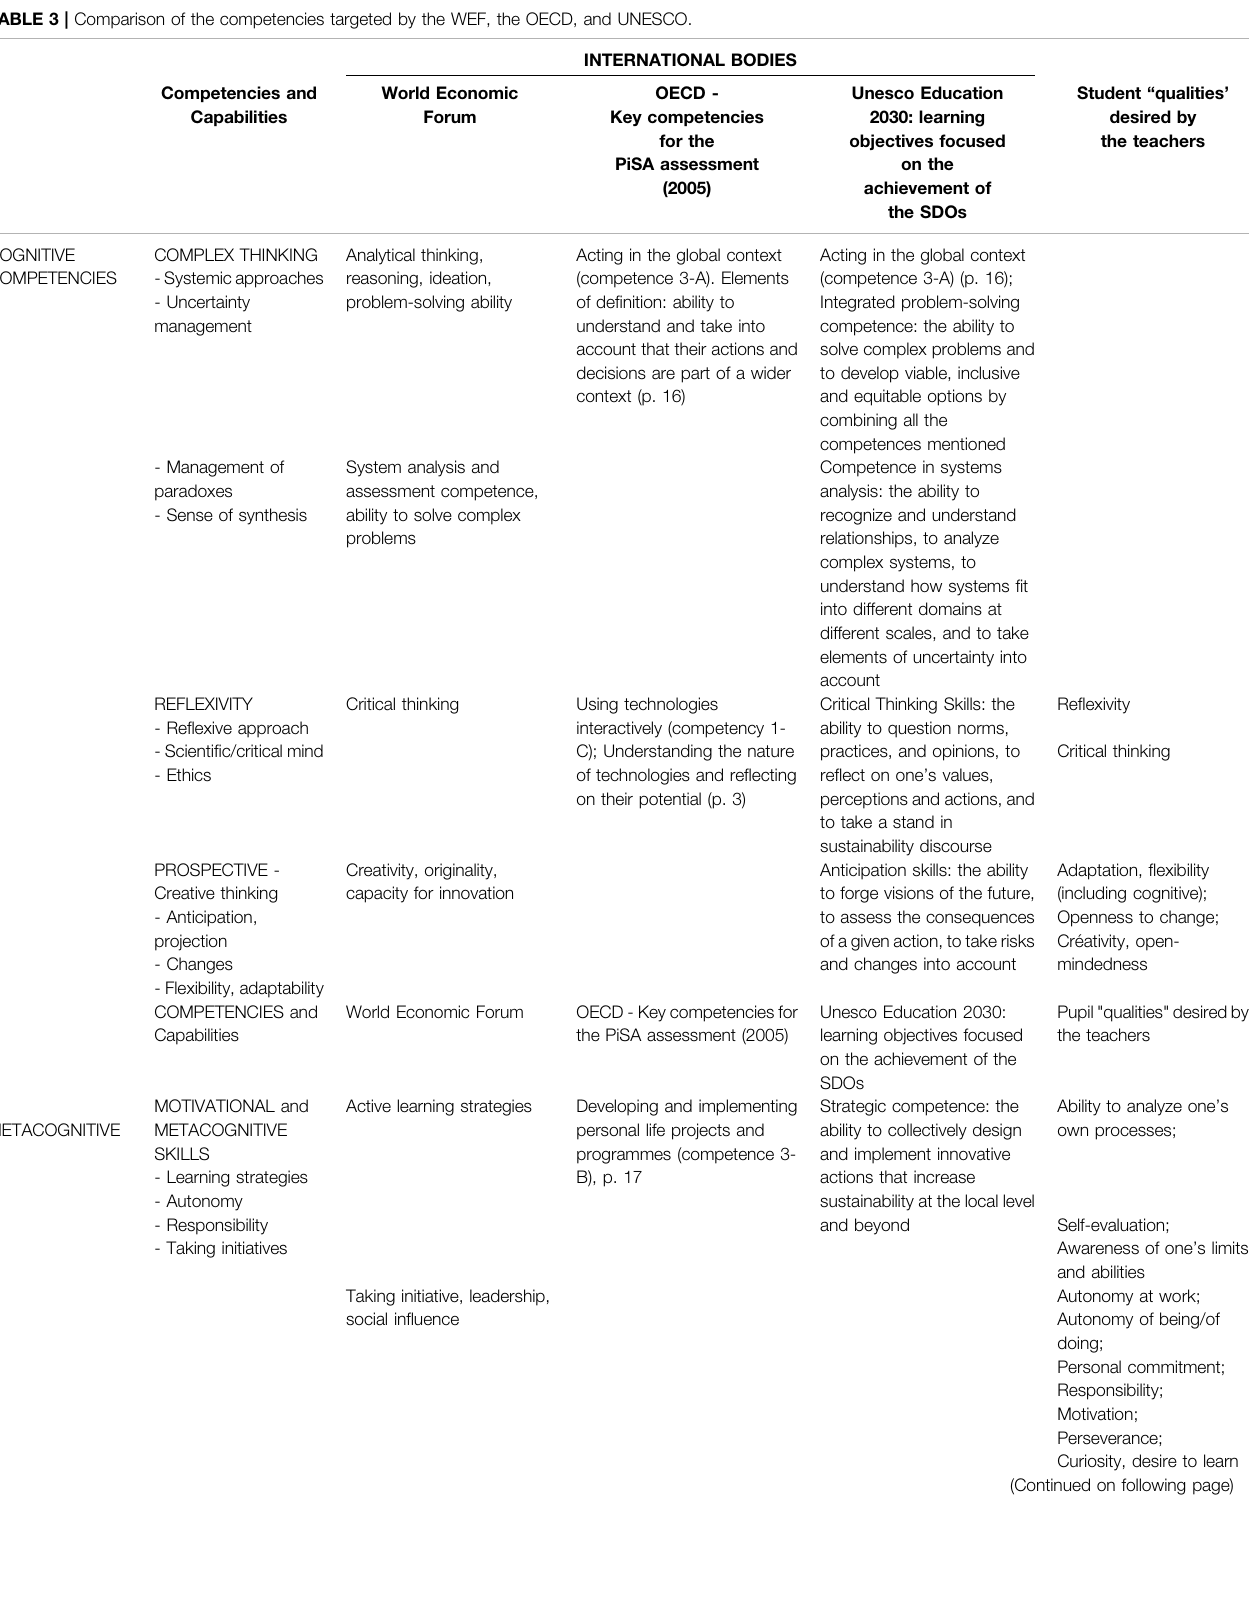
TABLE 3 | Comparison of the competencies targeted by the WEF, the OECD, and